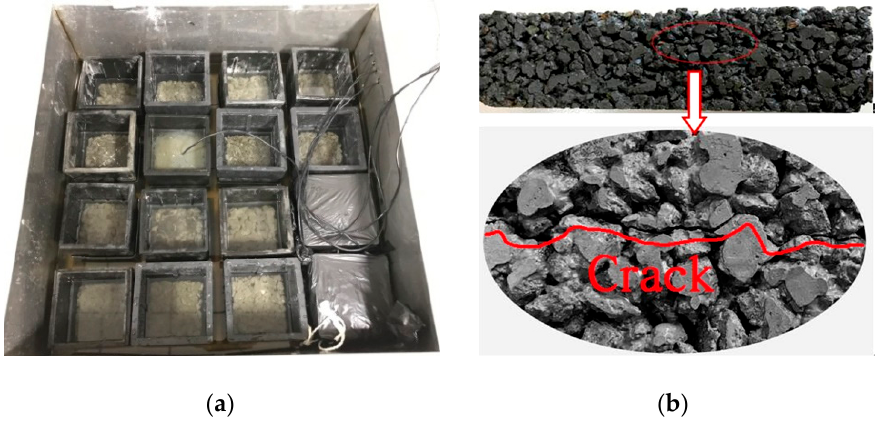
Figure 2. Freeze-thaw cycles test: ( a ) laboratory test; ( b ) specimen with cracks after freeze-thaw cycles.